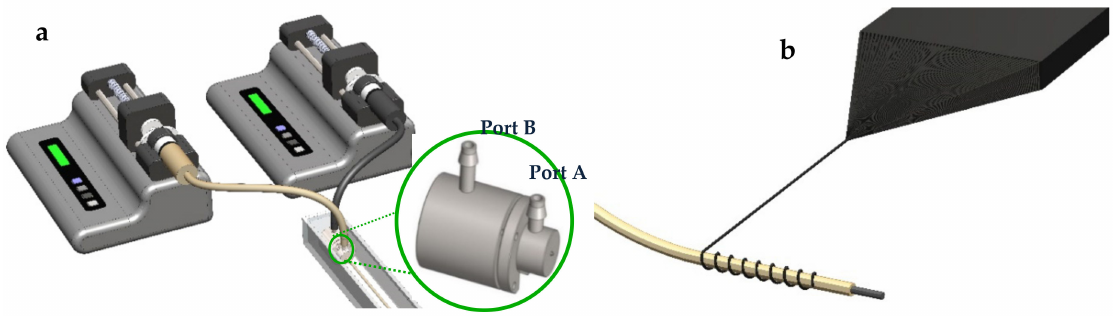
Figure 1. Schematic representation for ( a ) coaxial wet-spinning setup, and ( b ) CNT wrapping process. Core-sheath fibers of chitosan-PEDOT:PSS (with or without PEG) (abbreviated as Chit- PEDOT for ease of use) were spun into a bath of 1 M aqueous NaOH (Ethanol/H 2 O: 1/5). The applied injection rate used for PEDOT:PSS dispersion was 15 mL h − 1 and 28 mL h −